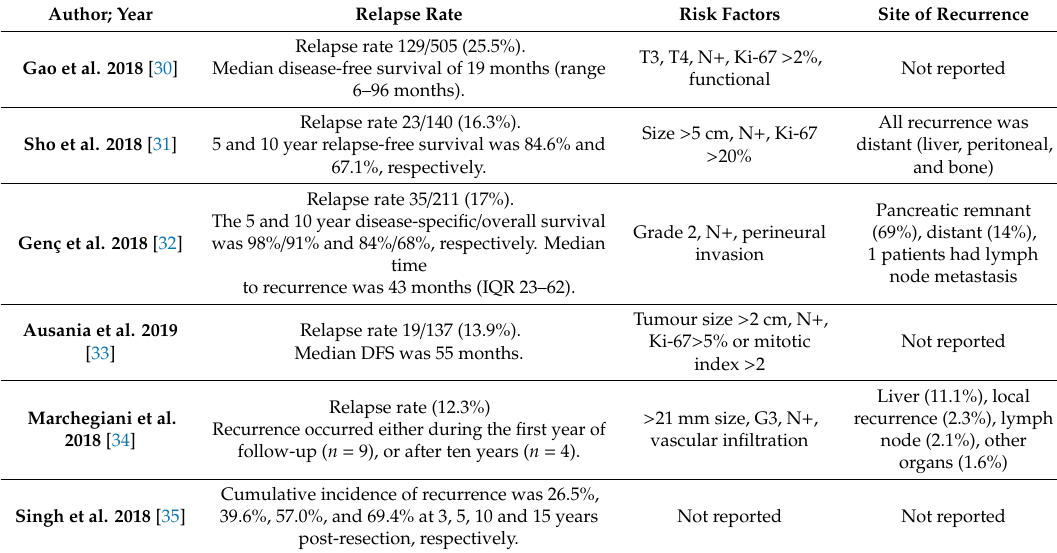
Table 1. Most relevant retrospective series in